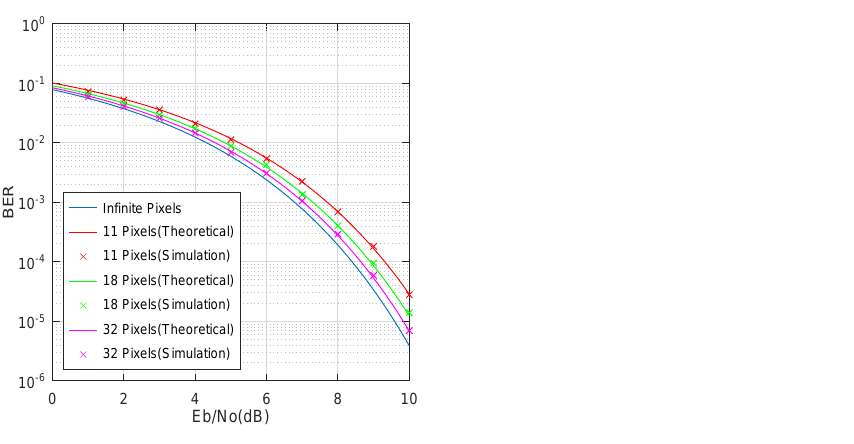
Figure 6. Theoretical results vs. simulation results for three different pixel numbers. The blue curve is plotted assuming an infinite number of pixels (i.e., ∆ V = 0).